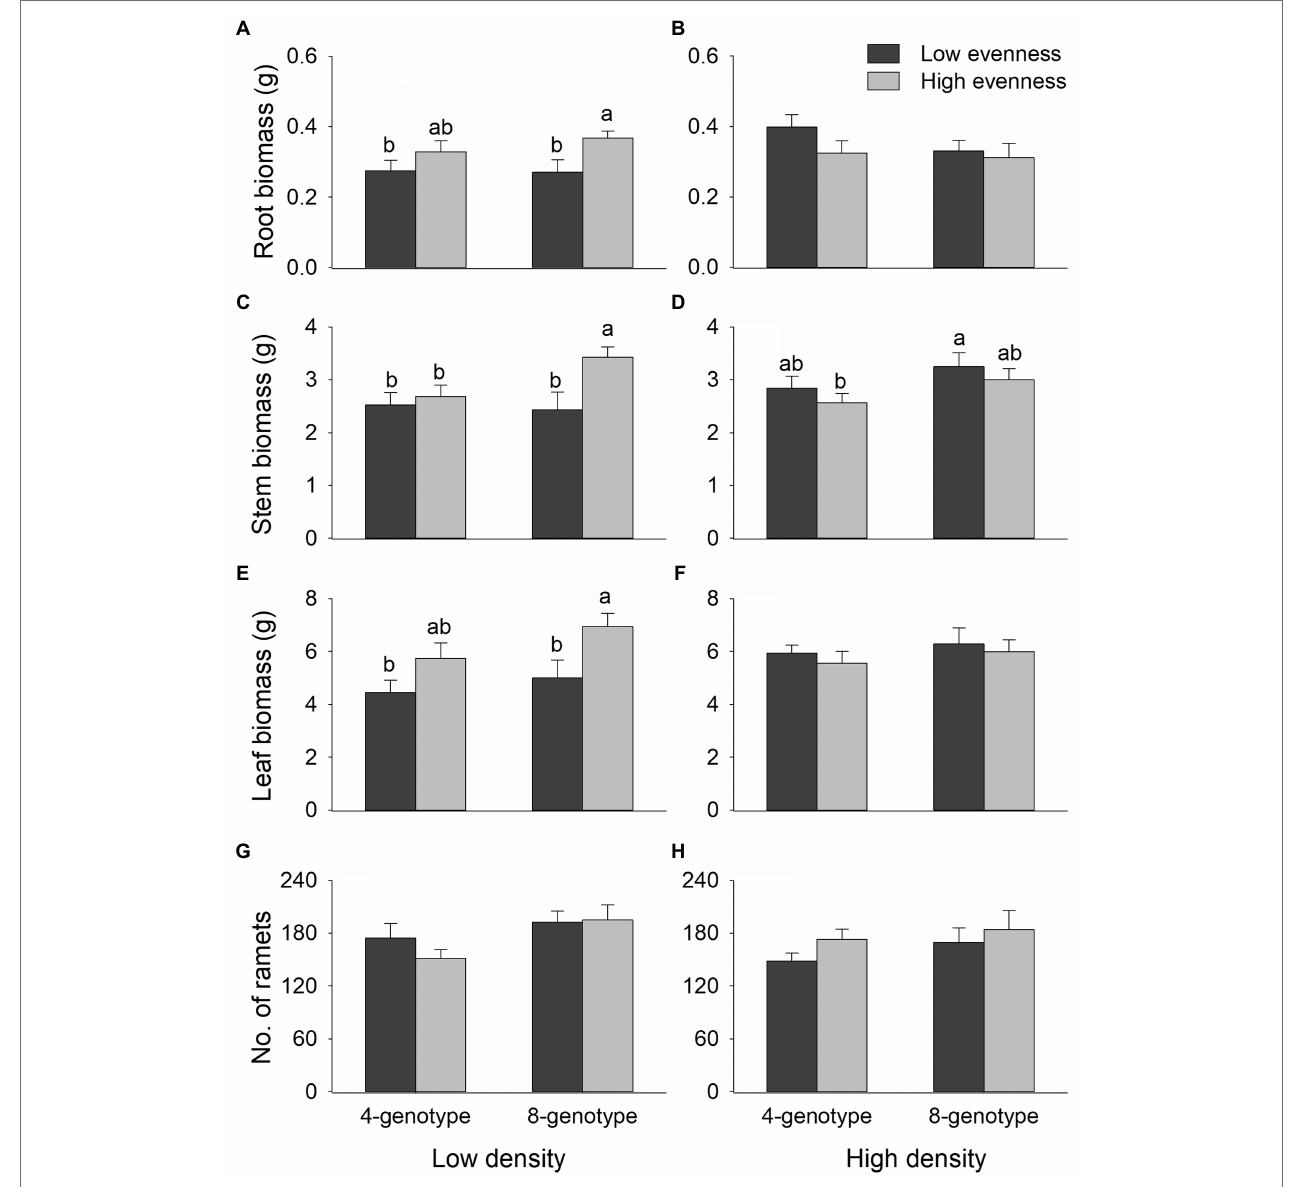
Table 1 for statistic results. Different letters (a–b) at the end of bars indicate significant difference in each